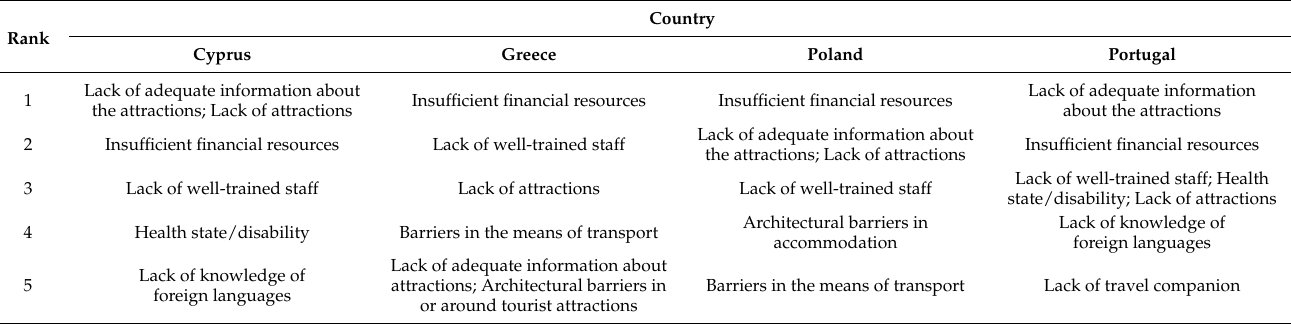
Table 4. Most important obstacles or barriers by country.